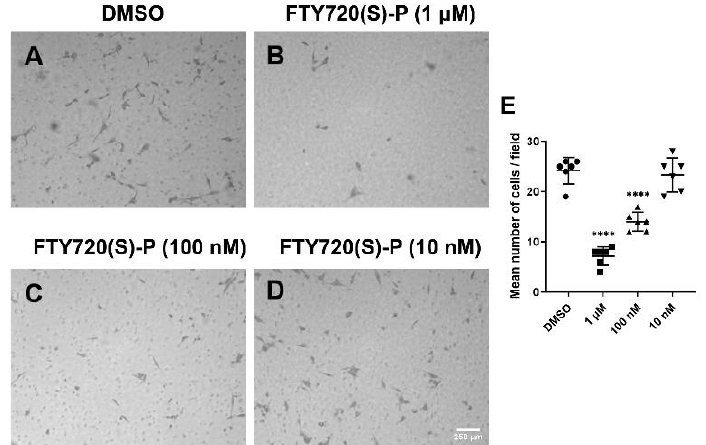
Figure 3. The S1PR agonist FTY720 inhibits ChEC migration. A suspension of ChECs was prepared in serum-free medium and added to the top of Transwell inserts and incubated for 4 h with medium containing agonist (in DMSO) or DMSO. Cells were fixed, stained with H&E, and the number of cells that migrated through the 8 μm pore size membrane was counted , as described in Methods.